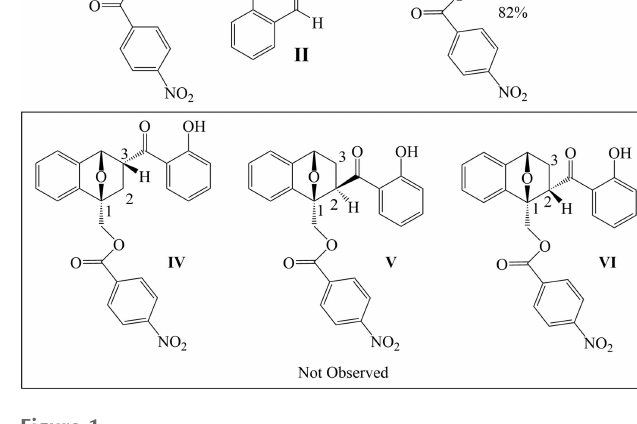
Figure 1 The reaction scheme.